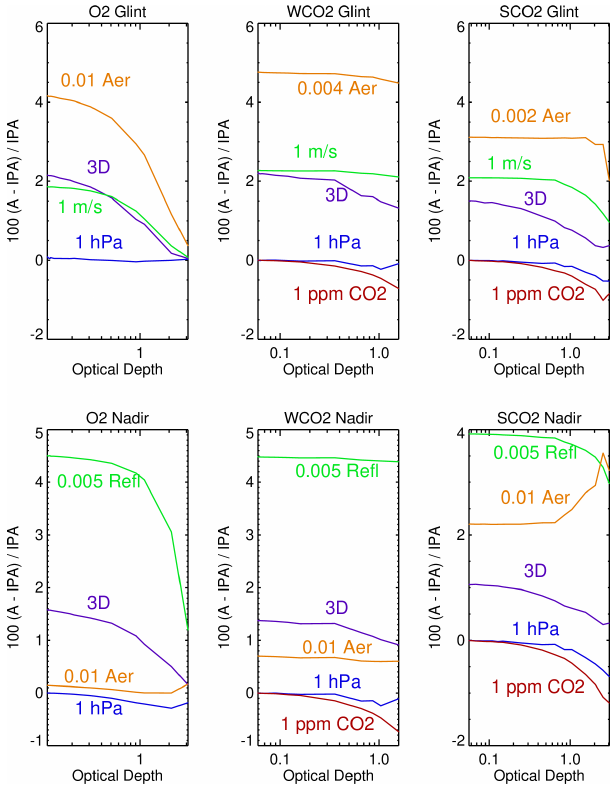
Figure 2. SHDOM 1D (IPA) and 3D radiative perturbations for ocean-glint- and land-nadir-viewing geometry using the same Fig. 9 cloud field. “A” in the y -axis title refers to 3D or 1D radiative pertur- bations. The 3D radiance perturbations for glint-viewing geometry are larger than the nadir-viewing geometry perturbations.